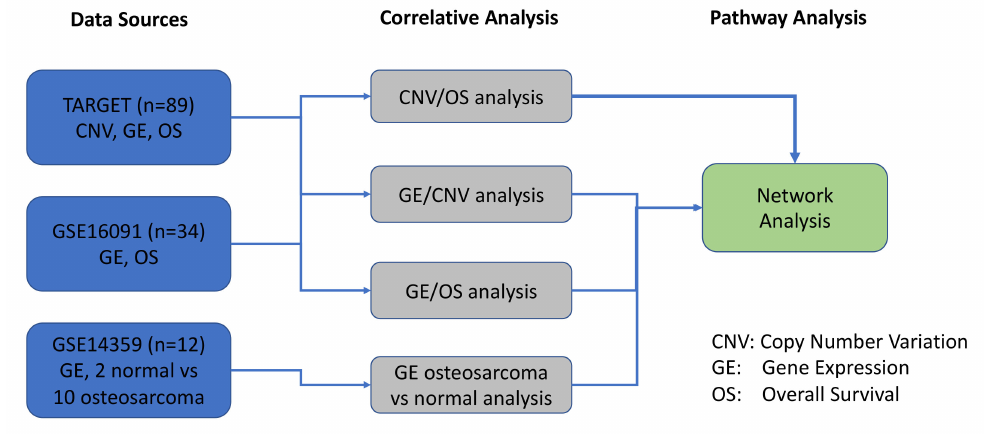
Figure 10. Schematic overview of the datasets and bioinformatics analyses conducted in the